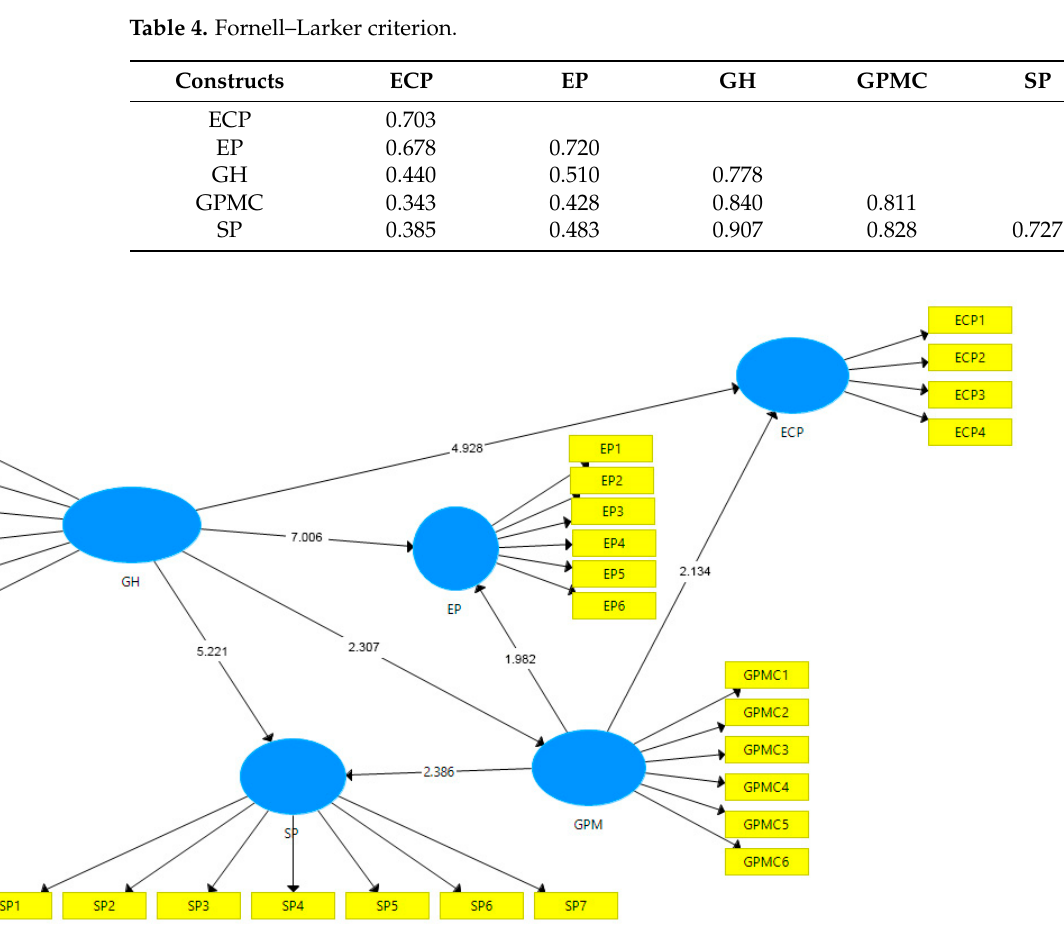
Figure 2. SEM model of the study.